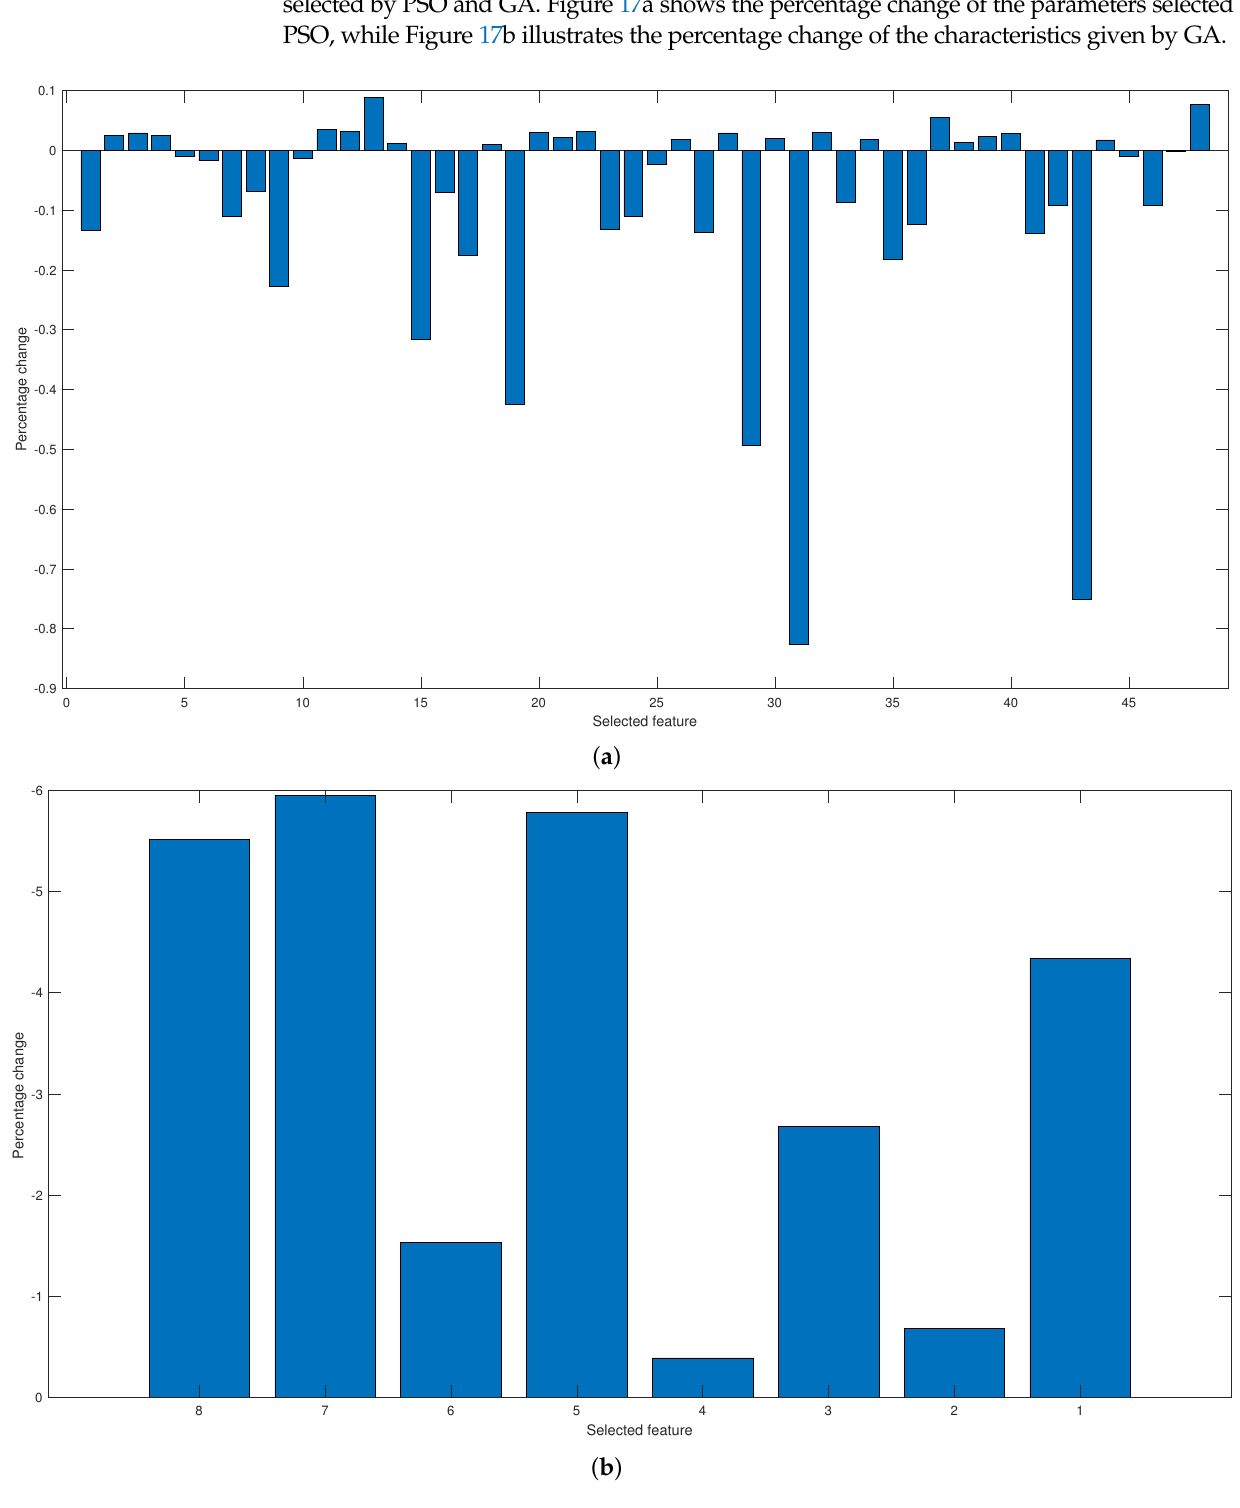
Figure 17. Plot of the classification percentage as a function of the number of iterations for ( a ) the linear kernel and ( b ) the Gaussian